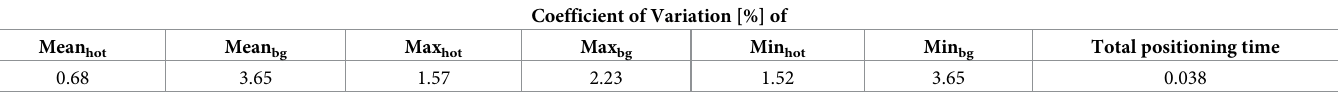
Table 2. Coefficient of variation of mean, max, min values and the total positioning time of 5 independent measurement of the phantom imitating 36 mm diameter sphere. Coefficient of Variation [%]